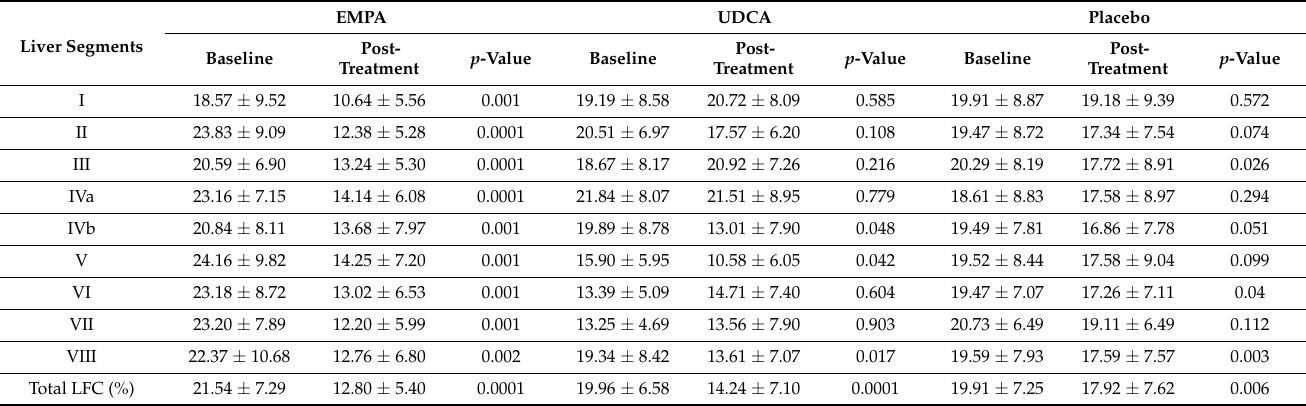
Table 2. Full liver fat fraction mapping by MRI-PDFF in study groups.